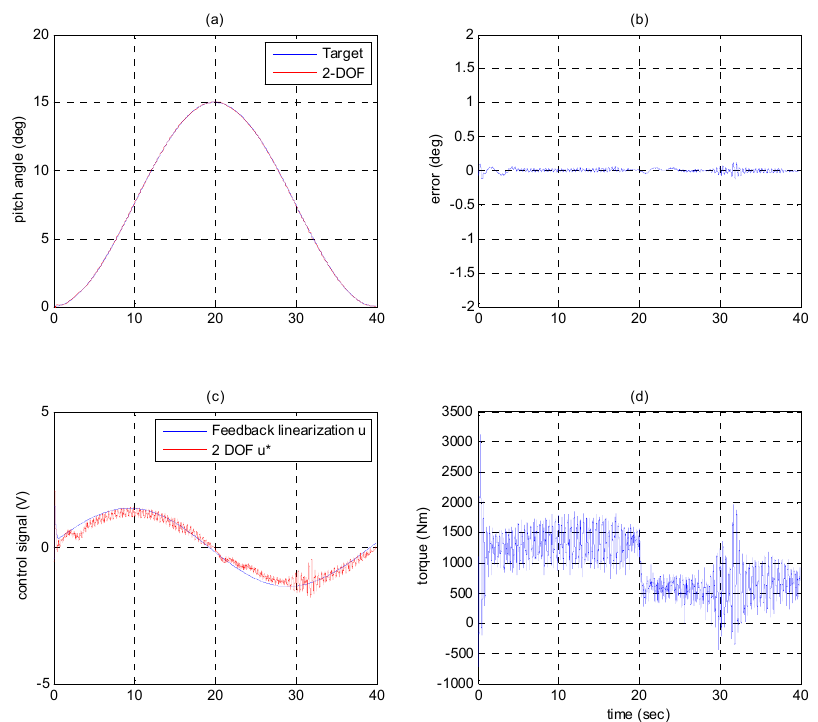
Figure 12. Experimental results sinusoid path control of pitch angle with amplitude of 15°, period 40 sec and load torque: ( a ) pitch angle response; ( b ) pitch angle control error; ( c ) comparison of input signals; ( d ) disturbance load.